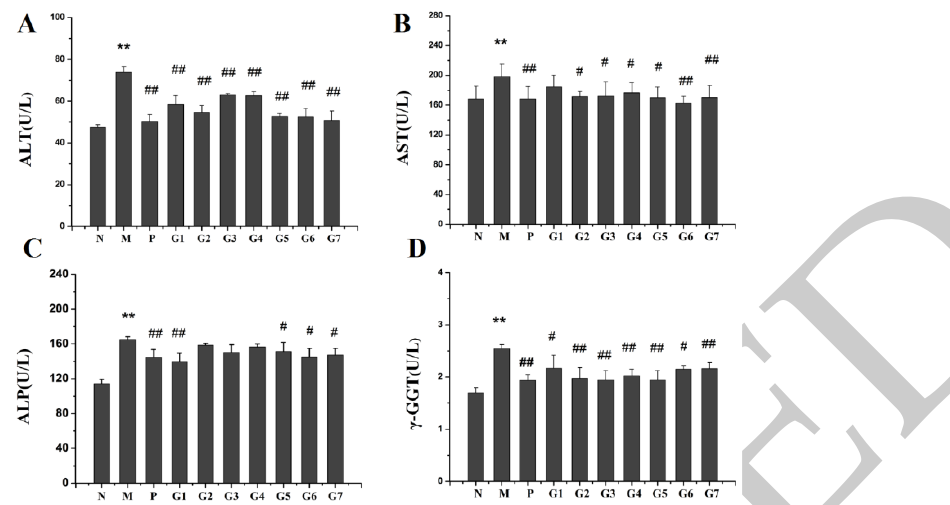
Figure 2. Effect of GA on levels of ALT ( A ); AST ( B ); ALP ( C ); and GGT ( D ) in ethanol-induced rats.